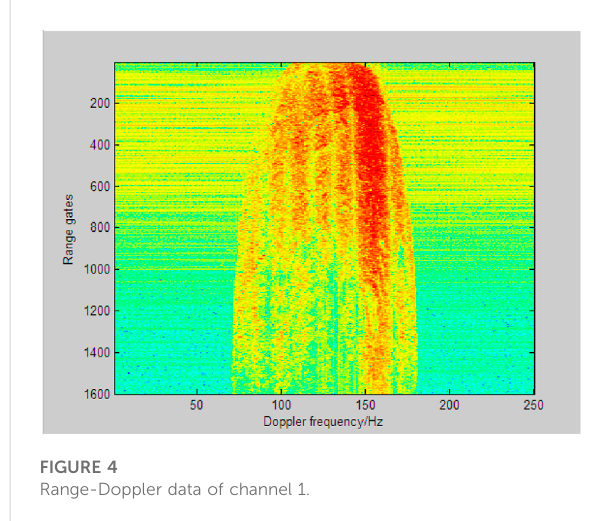
FIGURE 4 Range-Doppler data of channel